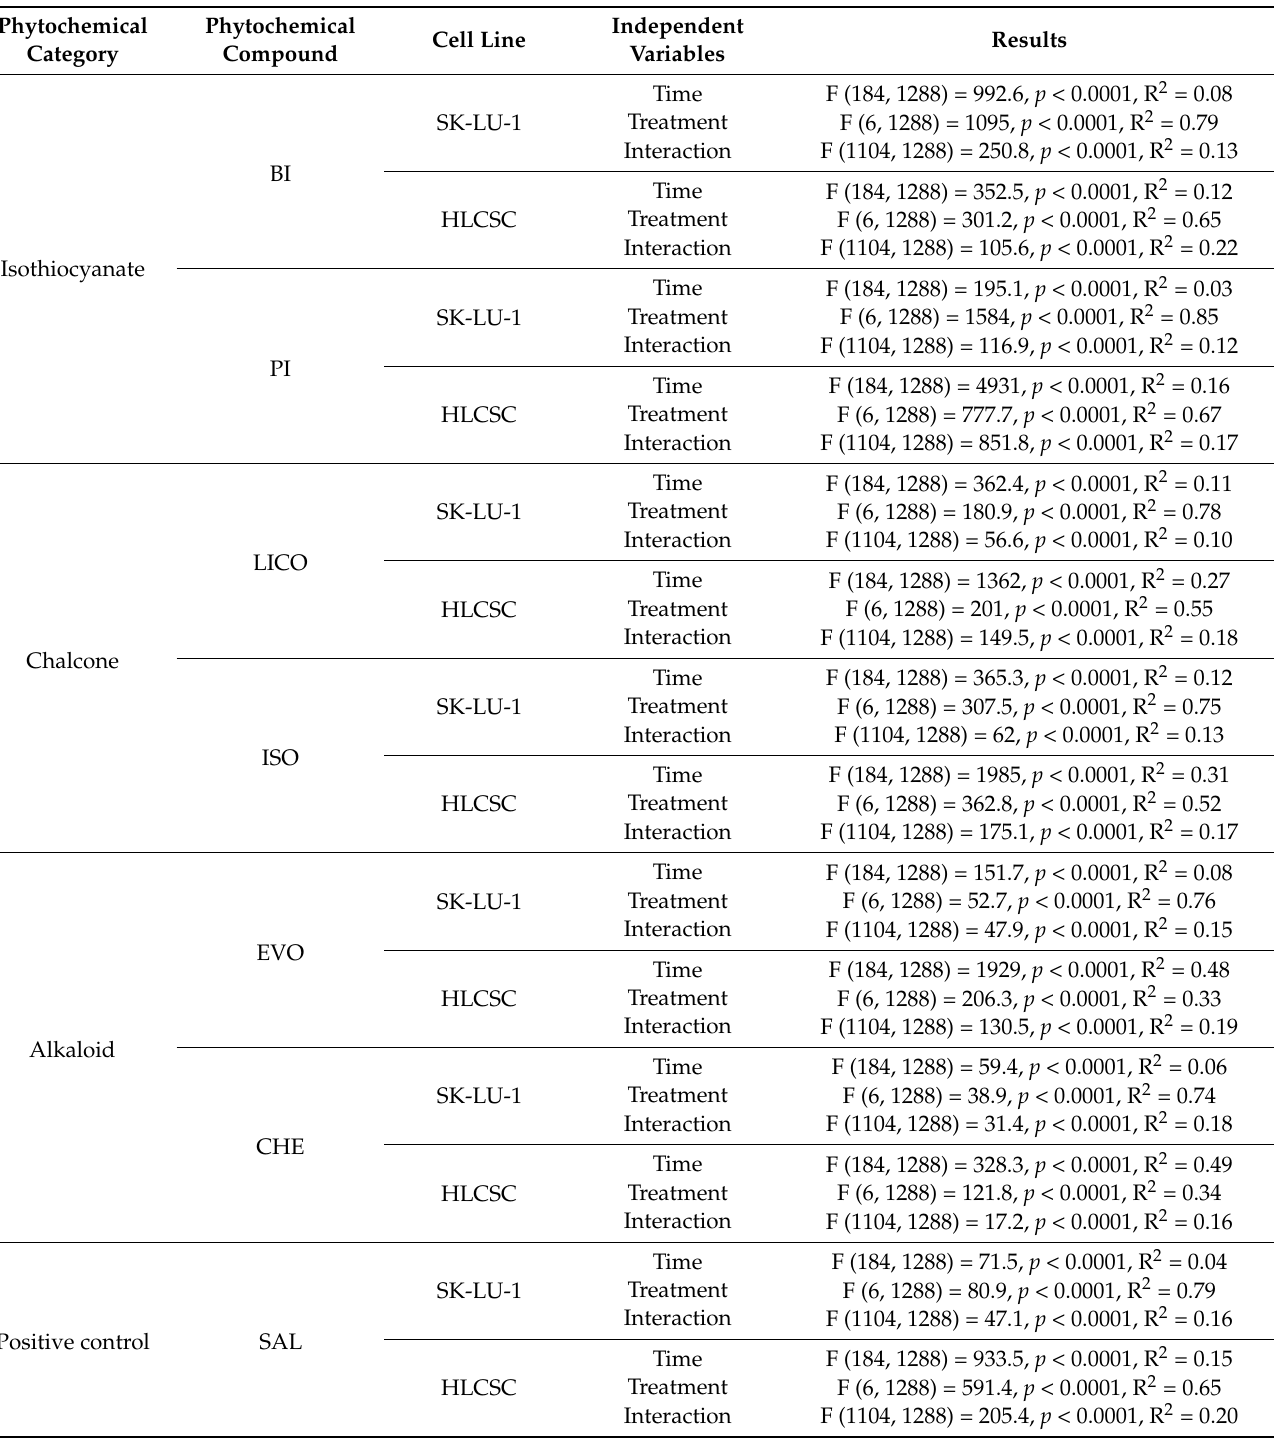
Table 1. Summary of the two-way repeated measures ANOVA analysis results of alkaloids, chalcones and isothiocyanates in SK-LU-1 and